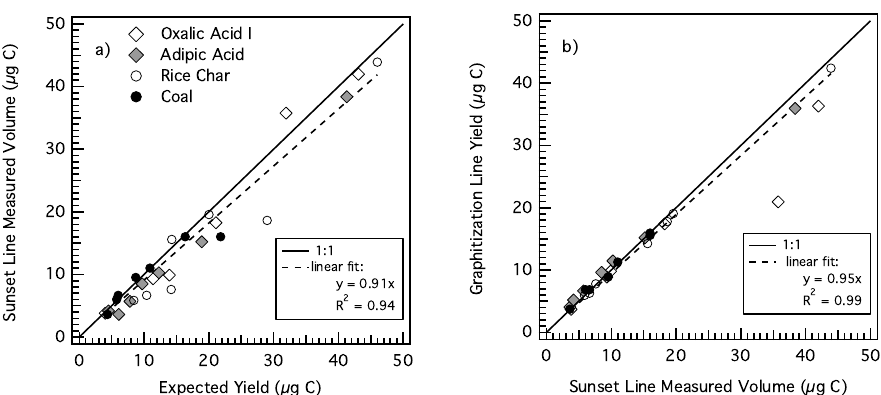
Figure 2. Sample recovery yield at each step of the analysis: (a) sample size measured at the calibrated volume of the Sunset vacuum line, compared to expected carbon yield; (b) sample size measured on the graphitization line compared to the sample size measured at the Sunset vacuum